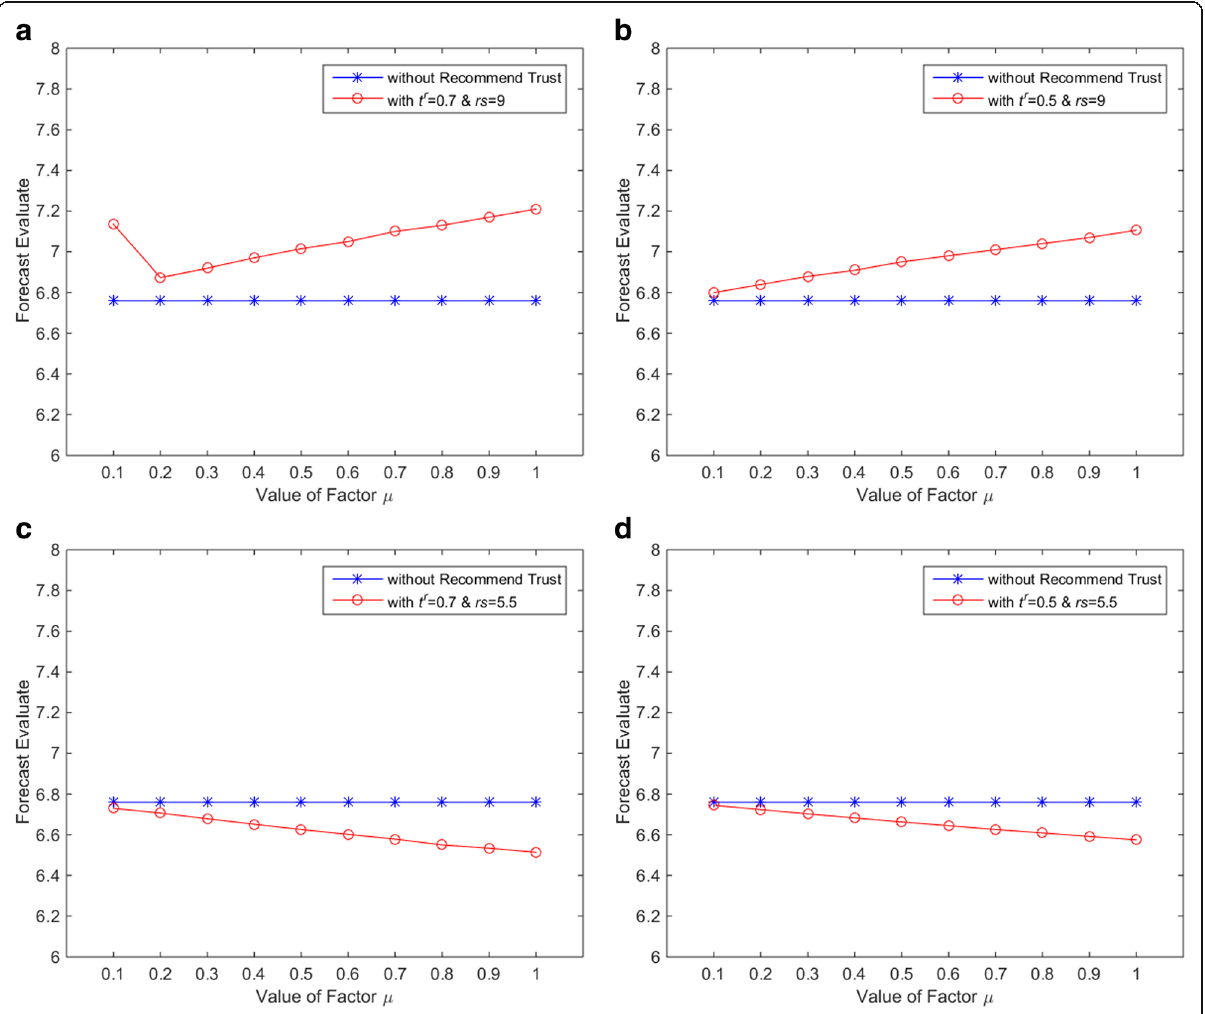
Fig. 6 Performance comparison on different μ . a The results of high recommend trust value and high score value. b The results of high recommend trust value and low score value. c The results of low recommend trust value and high score value. d The results of low recommend trust value and low score